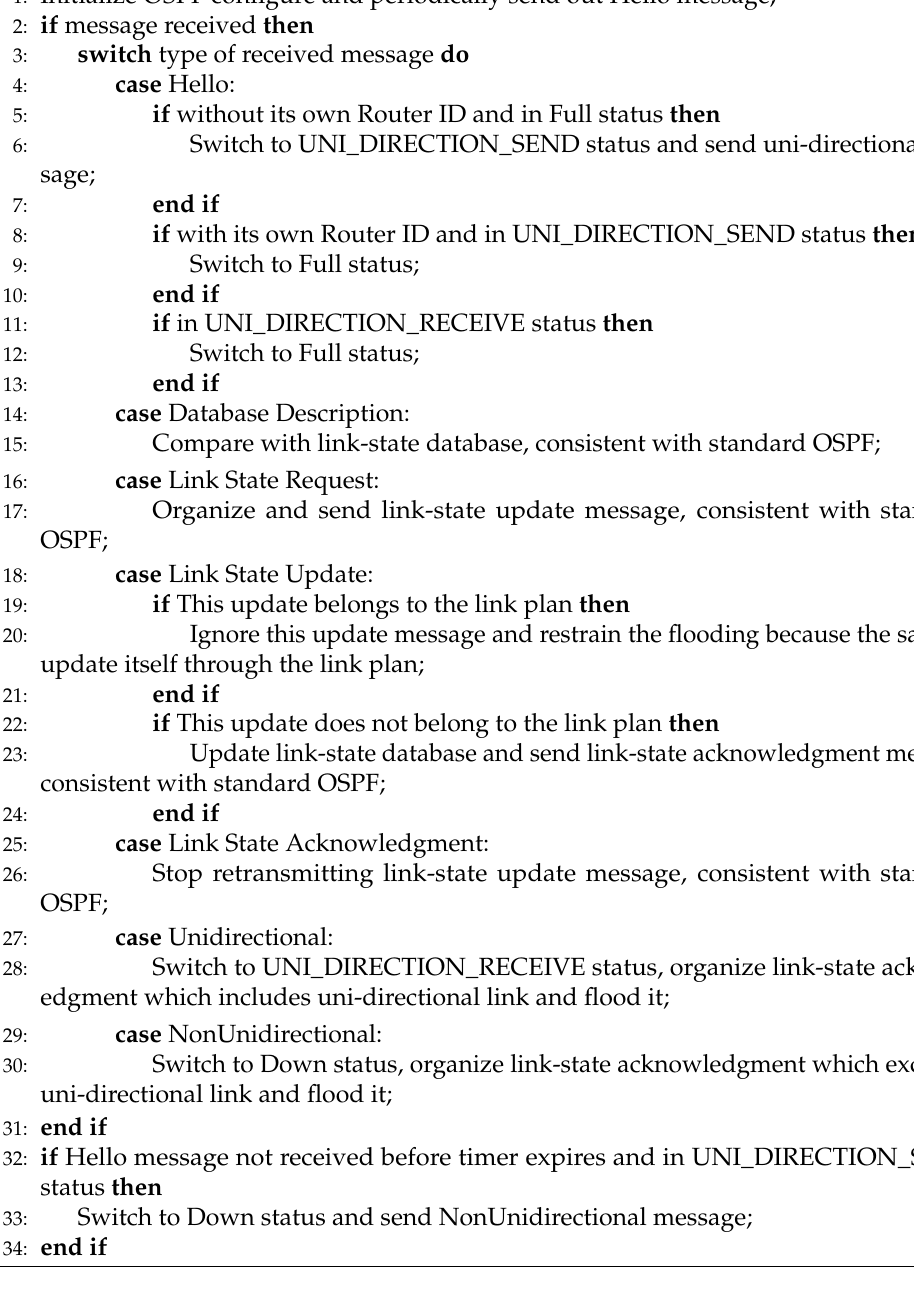
Algorithm 1 Optimized OSPF, Periodic Update of LSDB and Uni-directional Link